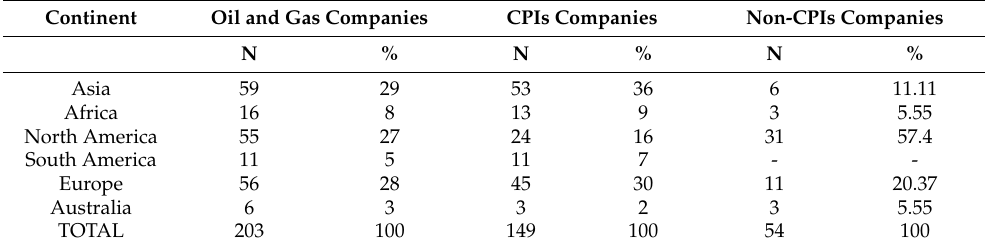
Table 3. CPI companies and non-CPI